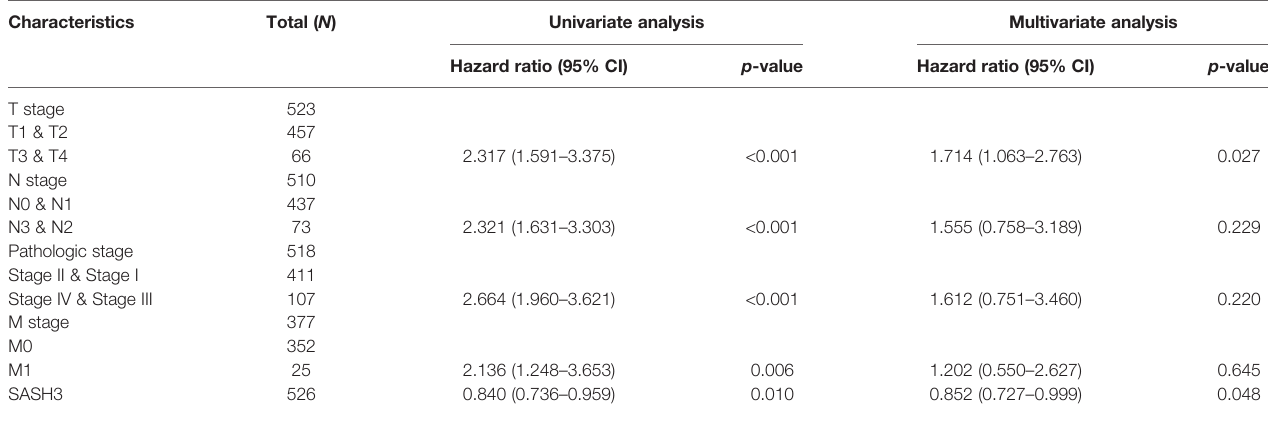
TABLE 1 | Univariate and multivariate Cox regression analyses of different parameters on overall survival in LUAD.